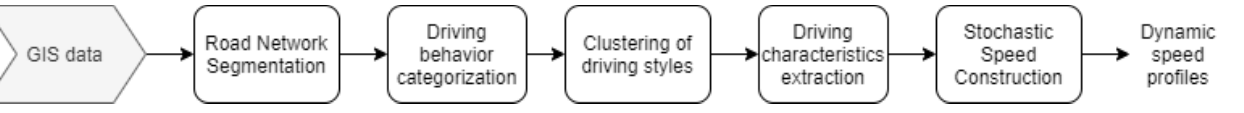
Figure 2. Illustration of the cascaded driving behavior